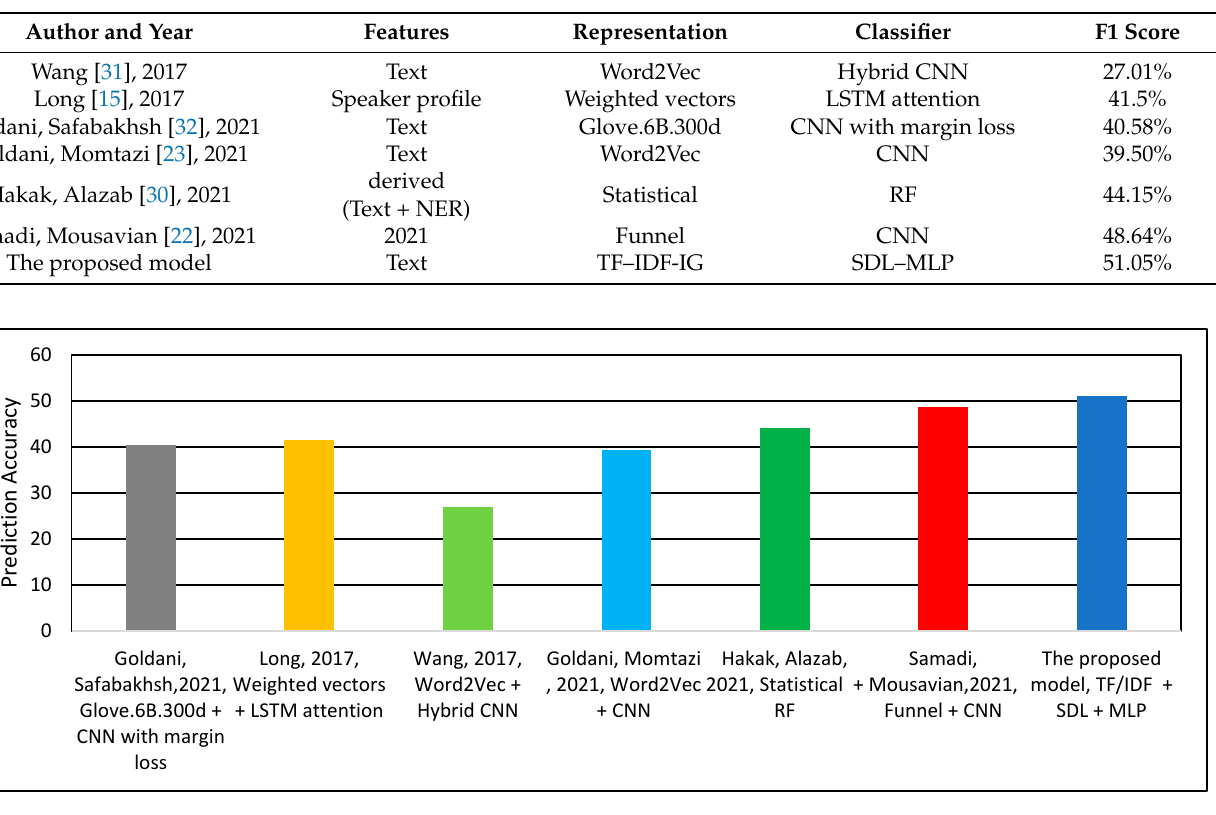
Figure 8. Classification Accuracy of the Models using LIAR Dataset.